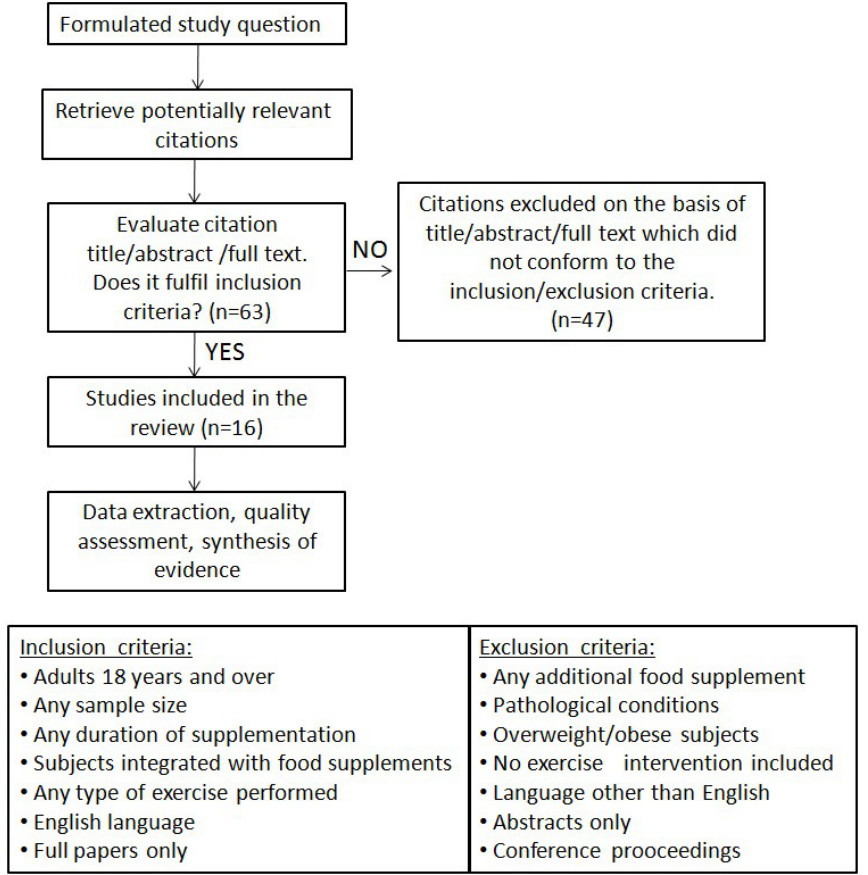
Figure 1. Methodological procedure of literature